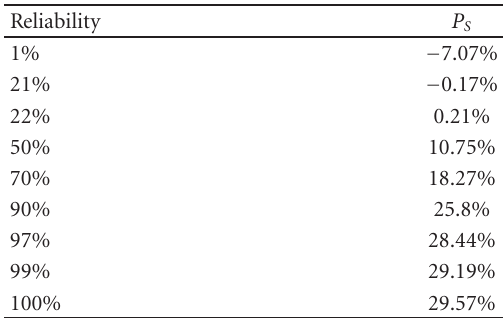
Table 13: XPA power savings